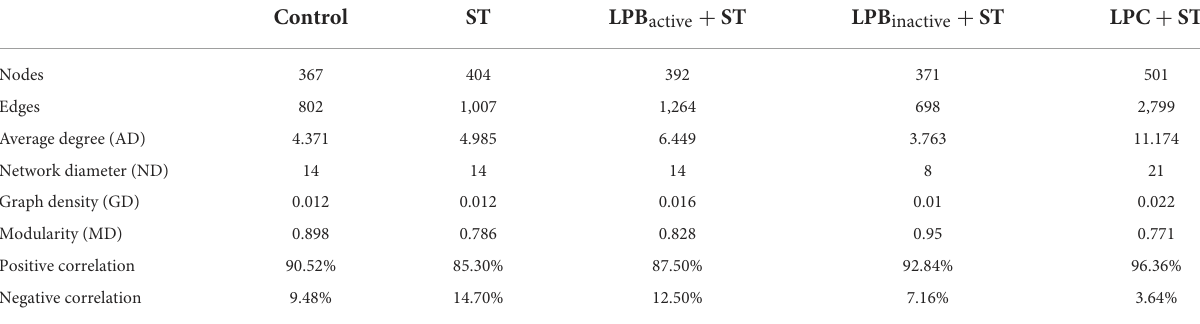
TABLE 1 Topological properties of co-occurrence